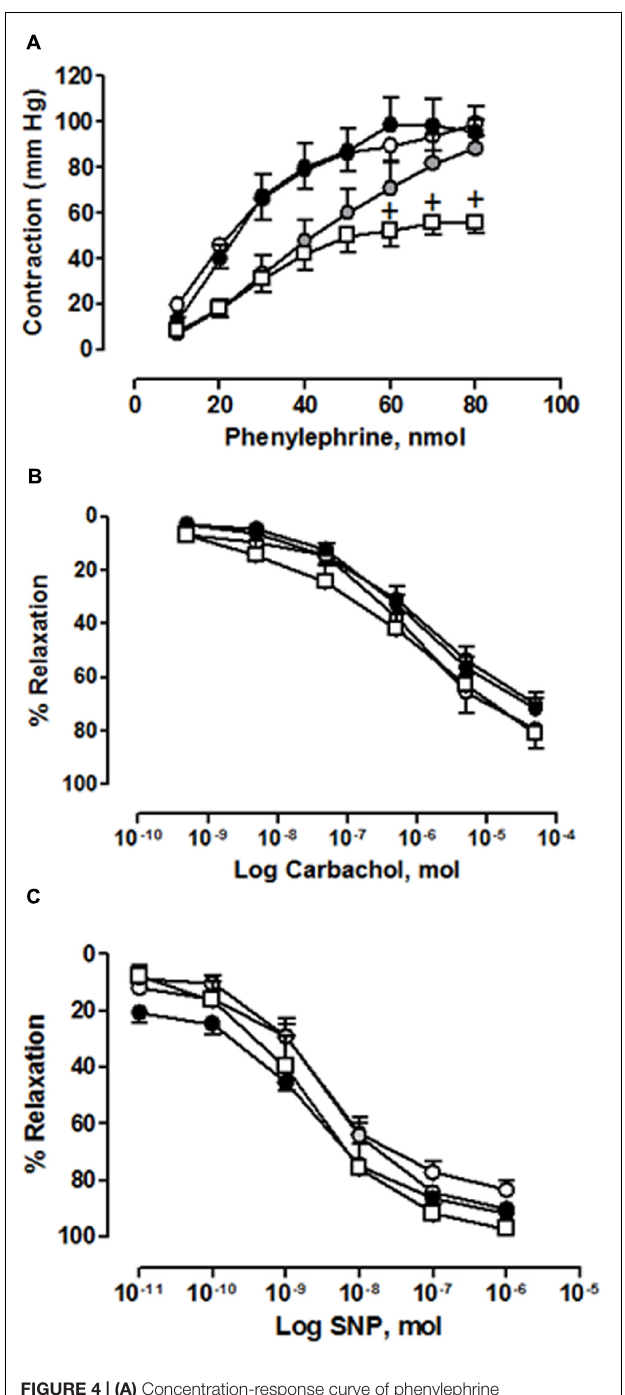
FIGURE 4 | (A) Concentration-response curve of phenylephrine (10 nmol–80 nmol), (B) concentration-response curve of carbachol (3 × 10 − 10 mol–3 × 10 − 5 mol) and (C) concentration-response curve of sodium nitroprusside (SNP) (3 × 10 − 11 mol–3 × 10 − 6 mol) in perfused mesenteric bed from animals chronically treated with saline (CONTROL, white circles) or cisplatin (CPT) at 1 mg/kg (gray circles), 2 mg/kg (black circles)